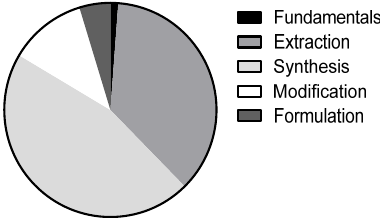
Figure 2. Graphical representation of the relative incidence of the subareas explored within deep eutectic solvents (DES)–polymer field [18].